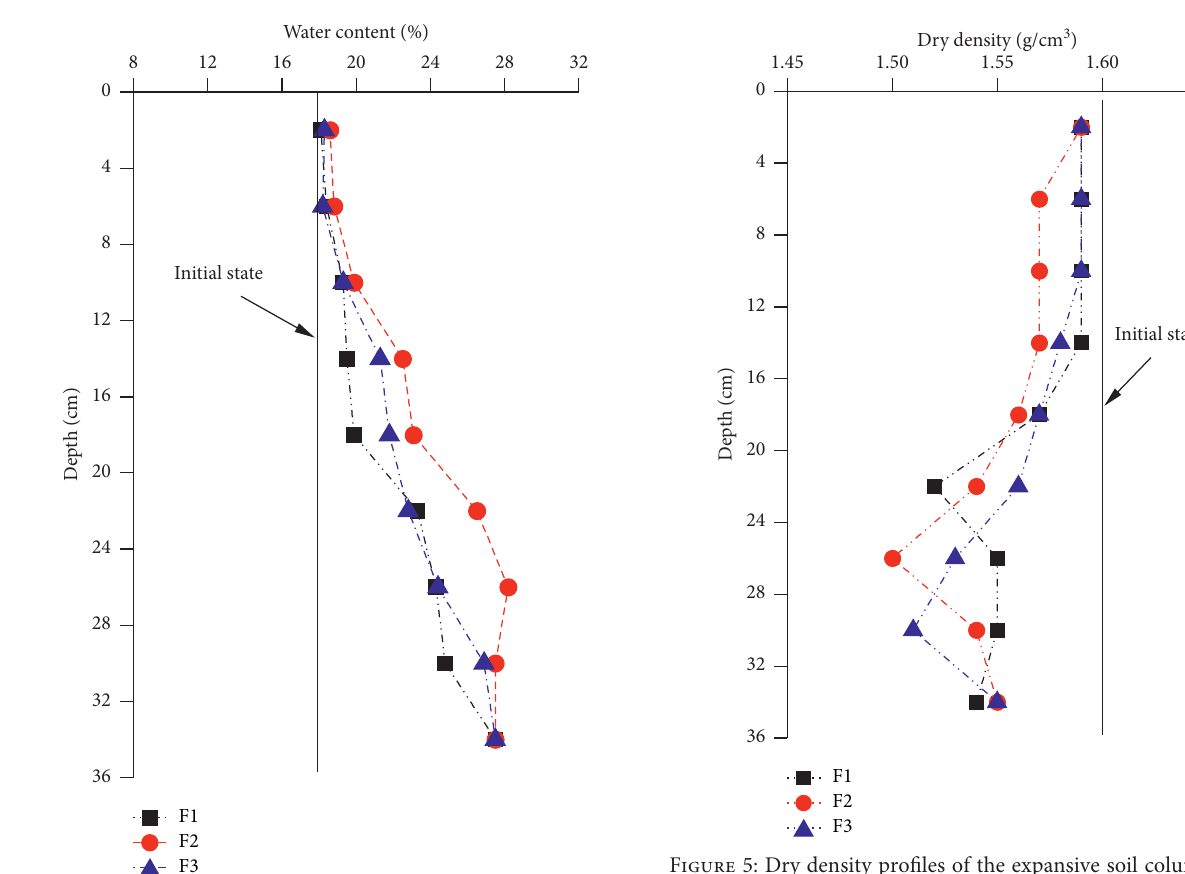
Figure 4: Water content profiles of the expansive soil columns after the freeze-thaw process.